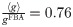
Metabolic adaptation: growth rate and correlation.A: Mean ± std of the growth rate during adaptation computed over 105 sample trajectories (solid lines, the dash line represents the median). The end-point of the trajectories is shown in the vertical histogram. The mean value at absorption is ⟨g⟩gFBA=0.76, and the median 0.83. The histogram is significantly skewed (z-test, p-value 0.05): around 47% of the trajectories reach a growth rate of 0.85g
pFBA. B: Mean ± std of the correlation between v
k and v
pFBA during adaptation (solid lines). At absorption, the mean of the correlation is 0.96. As can be seen in the histogram of the end-points, the distribution is highly skewed towards maximal correlation, with 68% of end-points above the mean. In fact the median is 0.98 (dashed line). C: The 3D histogram shows the correlation between v
pFBA and the end-point of the trajectories v versus the growth rate g reached by v. Of the trajectories reaching g/g
FBA > 0.85, 99% have correlation ≥ 0.85.